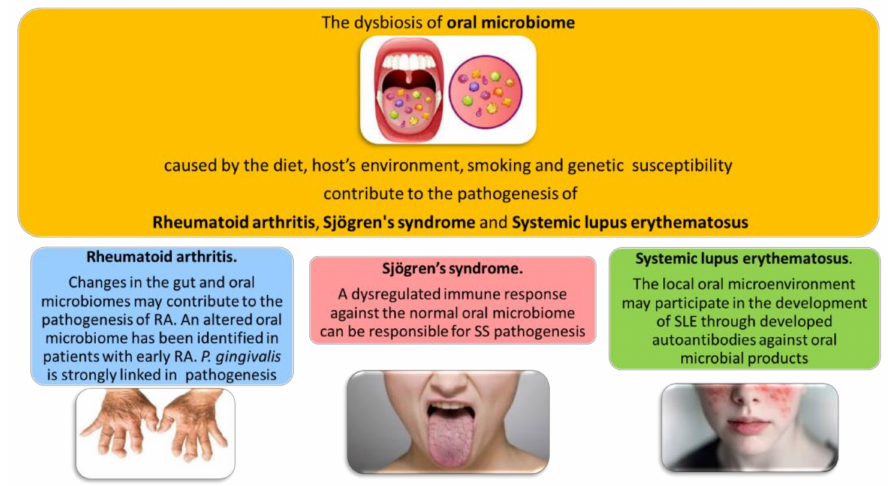
Figure 1. The dysbiosis of oral microbiome in rheumatic